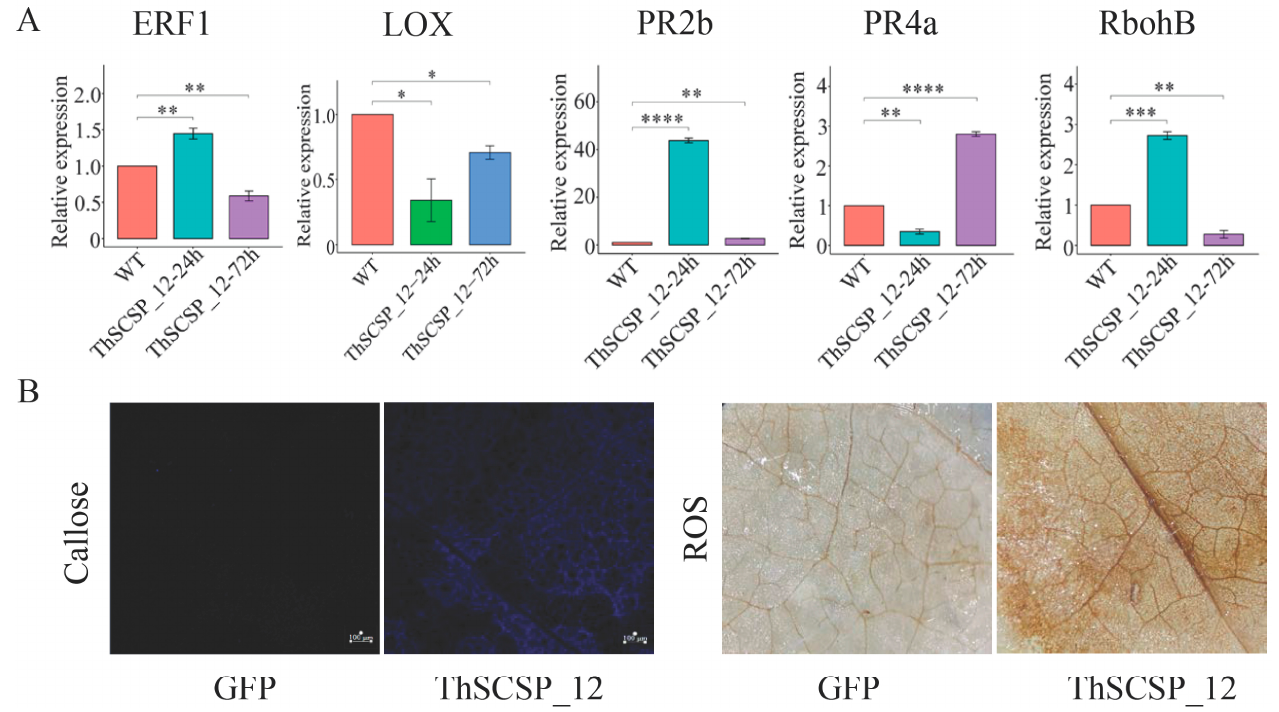
Figure 8. ThSCSP_12 triggers plant immunity responses in Nicotiana benthamiana . ( A ) Expression of genes related to plant immunity in N. benthamiana leaves transiently expressing ThSCSP_12 at 24 and 72 hpi (hours post-inoculation). Statistical analysis was performed by one-way ANOVA, followed by Tukey’s multiple comparison test. Error bars are the standard deviation (SD) of four independent replicates (* p < 0.05; ** p < 0.01; *** p < 0.001; **** p < 0.0001). ( B ) Accumulation of reactive oxygen species (ROS) and deposition of callose in N. benthamiana . For the observation of callose; bars = 20 µ m. These experiments were replicated three times with six leaves per biological replicate.